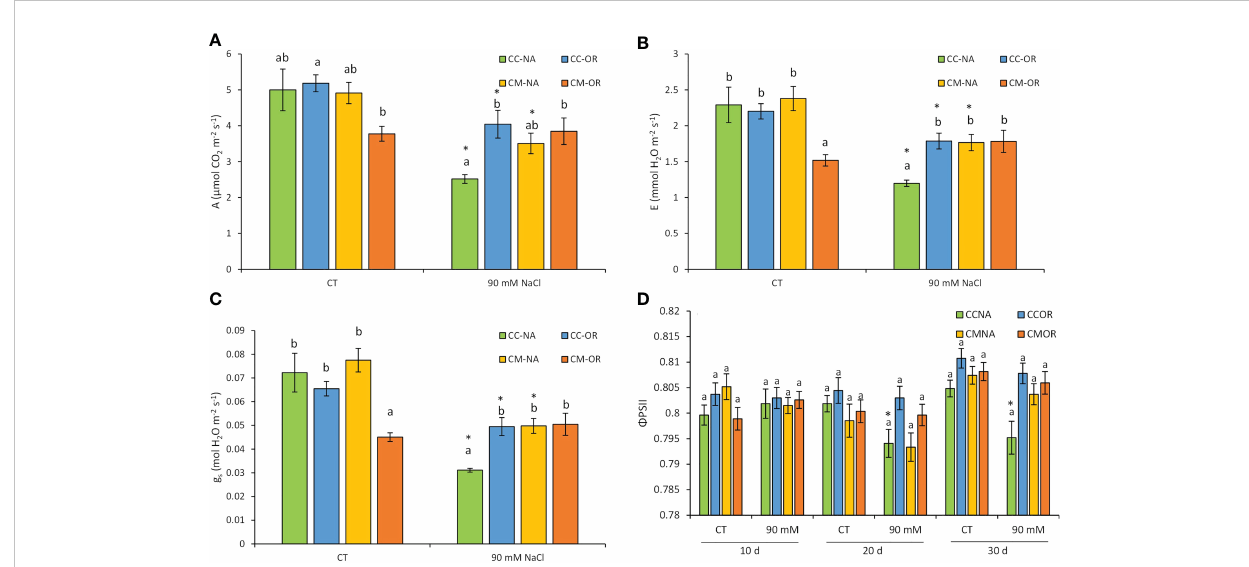
FIGURE 3 Photosynthesis-related parameters. Gas exchange parameters of leaves from control and salt-stressed plants of CC-NA (green bars), CC-OR (blue bars), CM-NA (yellow bars), and CM-OR (orange bars). (A) Net photosynthetic rate at 30 days. (B) Transpiration at 30 days. (C) Stomatal conductance at 30 days. (D) Quantum yield at 10, 20, and 30 days. Values are the mean of the data obtained from three leaves with four measurements per leaf ± standard error. Asterisks denote statistically signi fi cant differences in the stressed plants related to control at p ≤ 0.05. Different letters denote statistically signi fi cant differences among the rootstock/scion combinations for each treatment at p ≤